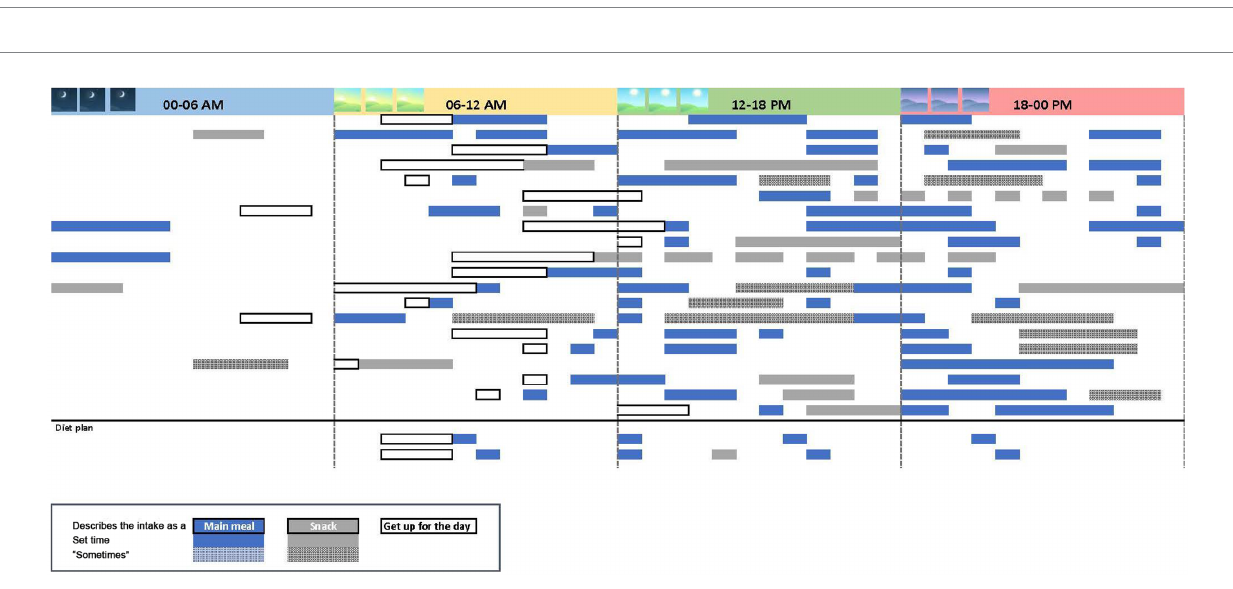
FIGURE 2 Illustration of individual meal patterns based on the dietary interviews. Each horizontal bar represent one patient. Long horizontal bars indicate time intervals for meals/snacks, rather than fixed hours. Two patients followed strict meal plans due to anorexia